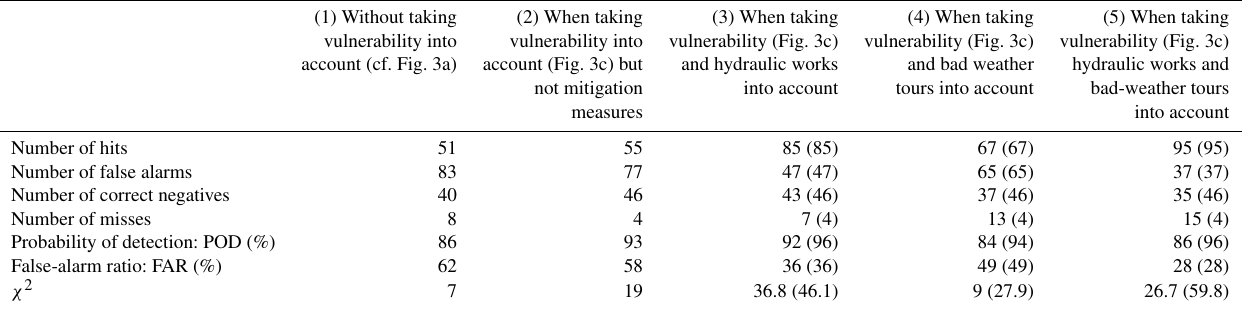
Table 5. Performance criteria assessing the predictive power of the IRIP model in identifying sections with a proven risk using different methods to take into account vulnerability and mitigation measures: without taking vulnerability into account according to Fig. 3a (column 1), when taking vulnerability into account according to Fig. 3c but not mitigation measures (column 2), and when taking vulnerability into account according to Fig. 3c and mitigation measures (columns 3 to 5). In columns (3) to (5), the figures correspond to step 4.2, and those in brackets correspond to step 4.1 of the